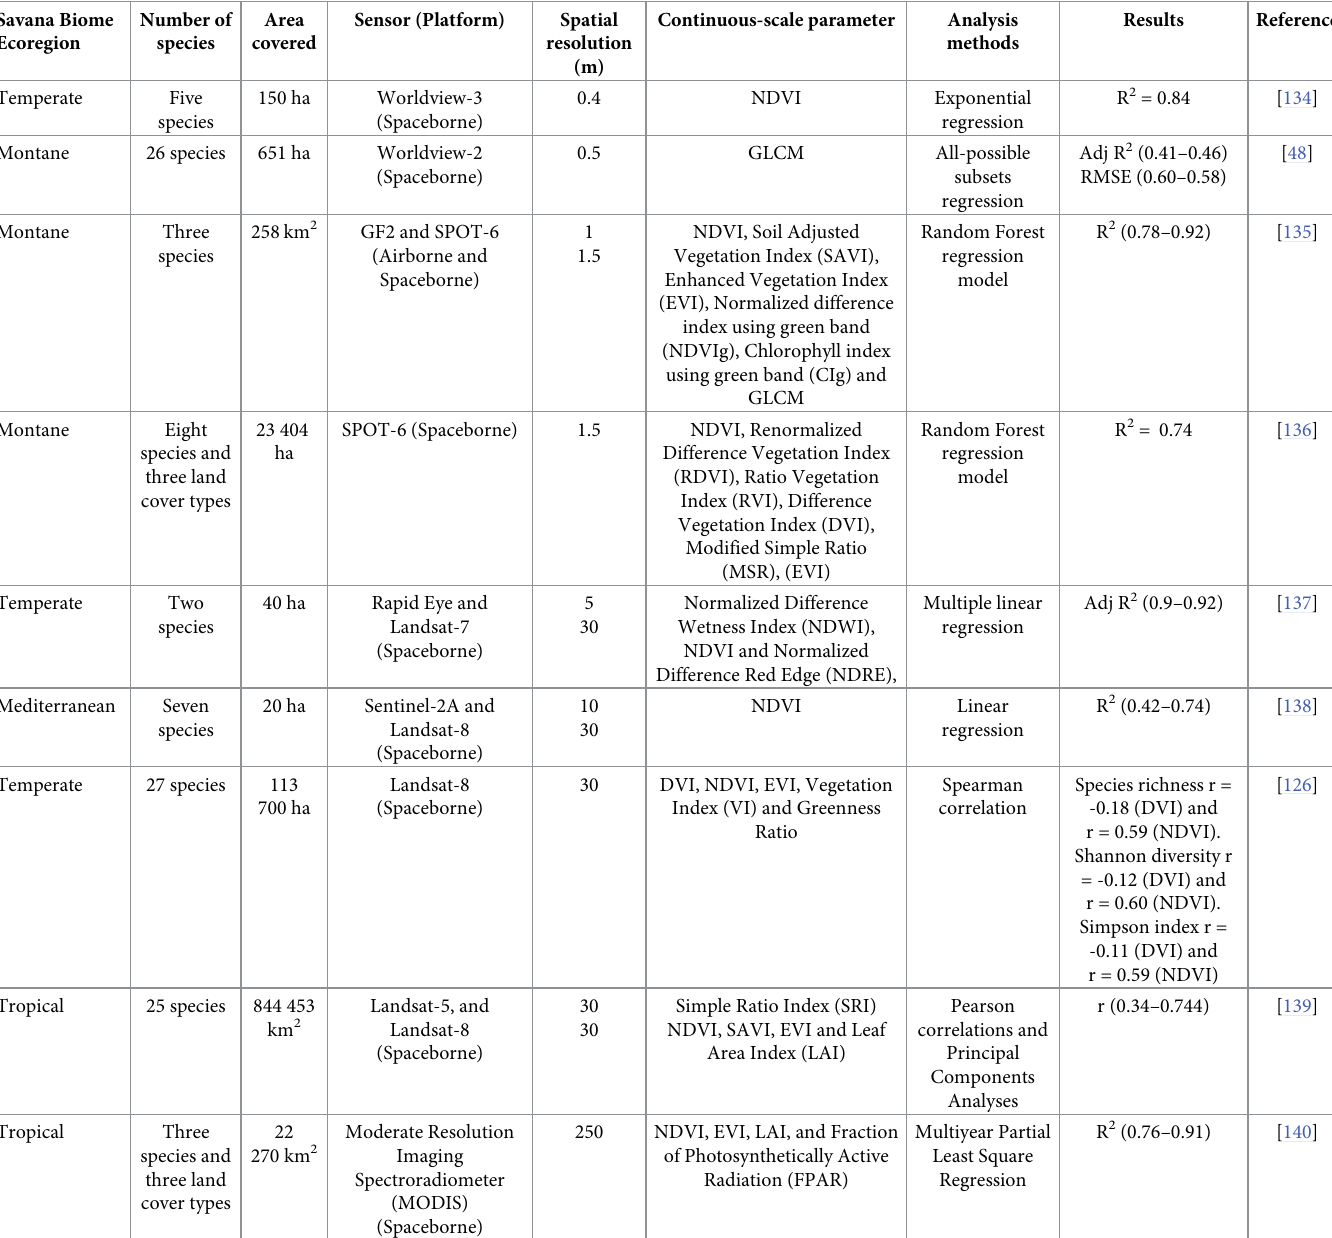
Table 4. Examples of studies that quantified woody plant species diversity in the savanna using optical remote sensing and continuous-scale. Savana Biome